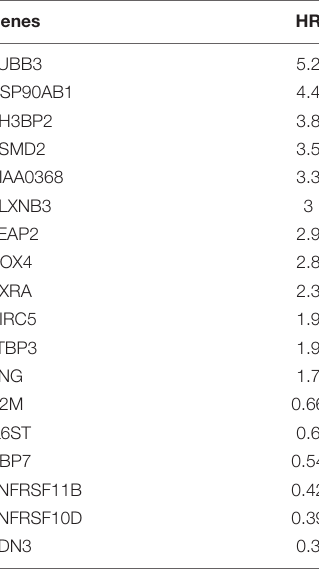
TABLE 2 | Model information about